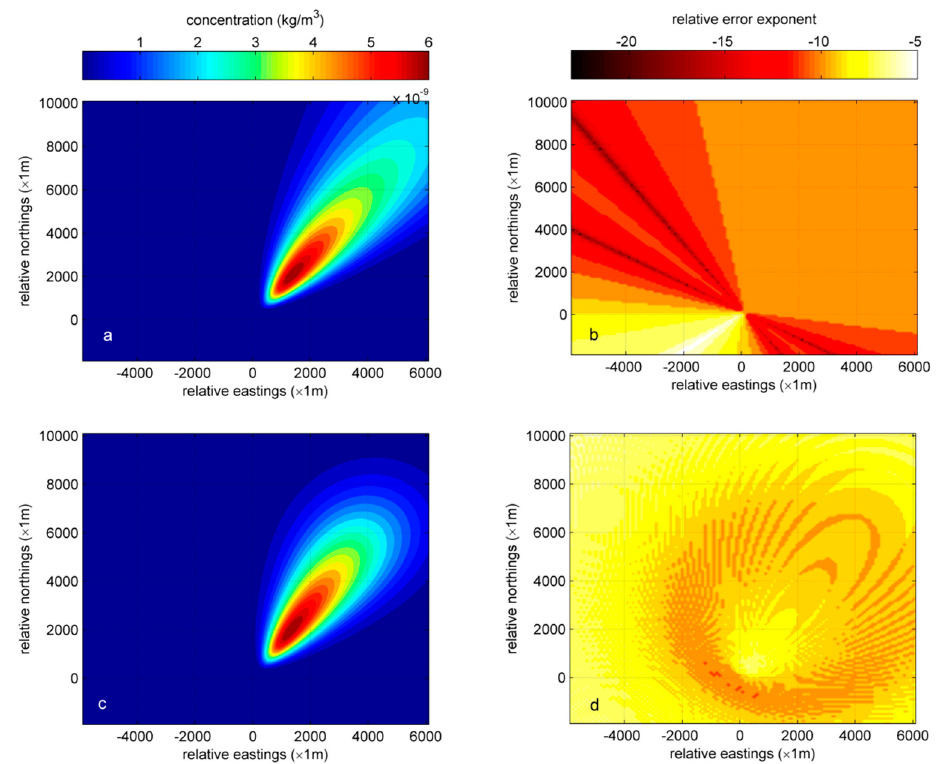
Figure 6. Relative analysis results of Gaussian plume model, Gaussian multi-puff model and their PF variation. ( a ) Modeled concentration distribution at 11:00; ( b ) Relative error exponent distribution matches to modeled concentration distribution; ( c ) Modeled concentration distribution at 11:00; ( d ) Relative error exponent distribution matches to modeled concentration distribution).